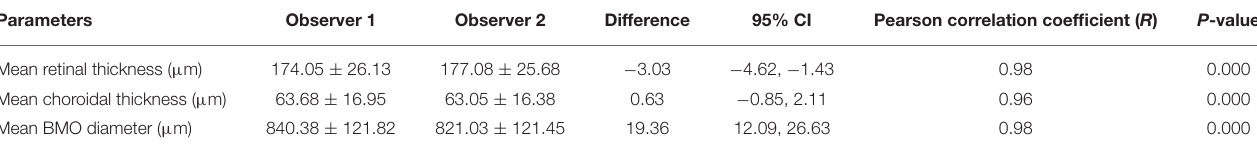
TABLE 3 | Inter-observer analysis showing the reproducibility of measurements performed by two observers independently.